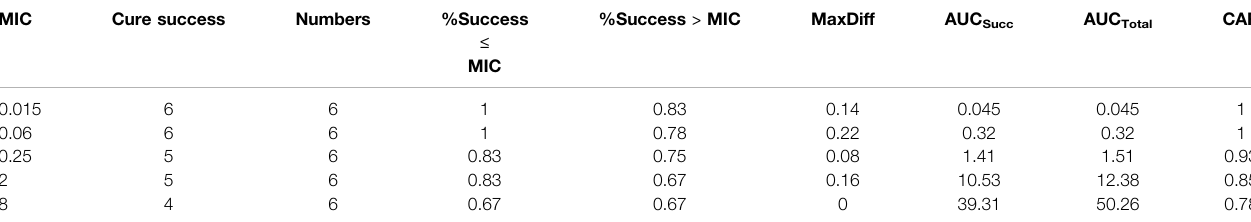
TABLE 7 | Window of differing MaxDiff and CAR values.